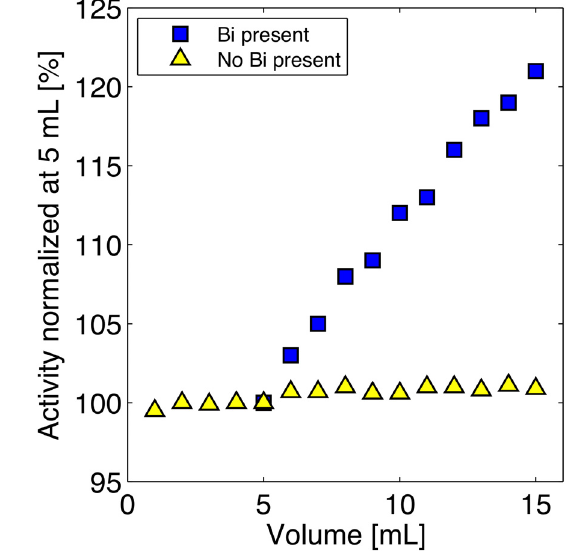
Figure 4. Graphs depicting the change in dose calibrator reading of a fixed amount of 211 At when the concentrations of bismuth are changed. ( A ) Dependence of bismuth concentration vs . dose calibrator reading for a fixed (5 mL) quantity of HNO volume vs . dose calibrator reading in the presence and absence of bismuth. Values in each graph have been decay corrected and normalized to; ( A ) the no added bismuth reading, or ( B ) the 5 mL